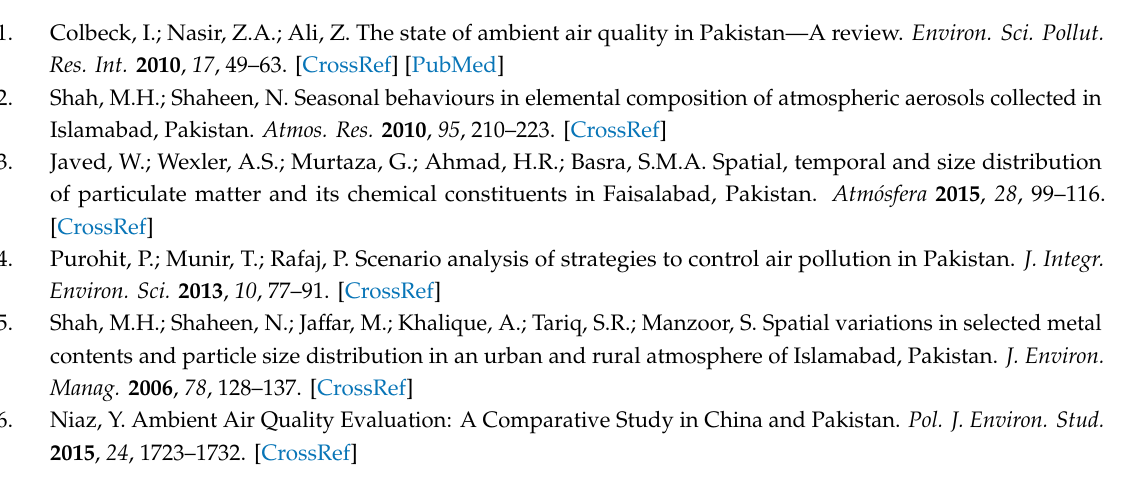
Table S1: A summary of the existing literature reporting air pollution status in Pakistan. Author Contributions: All the authors contributed to this study. S.A.U.R., Y.C. conceptualized the study.